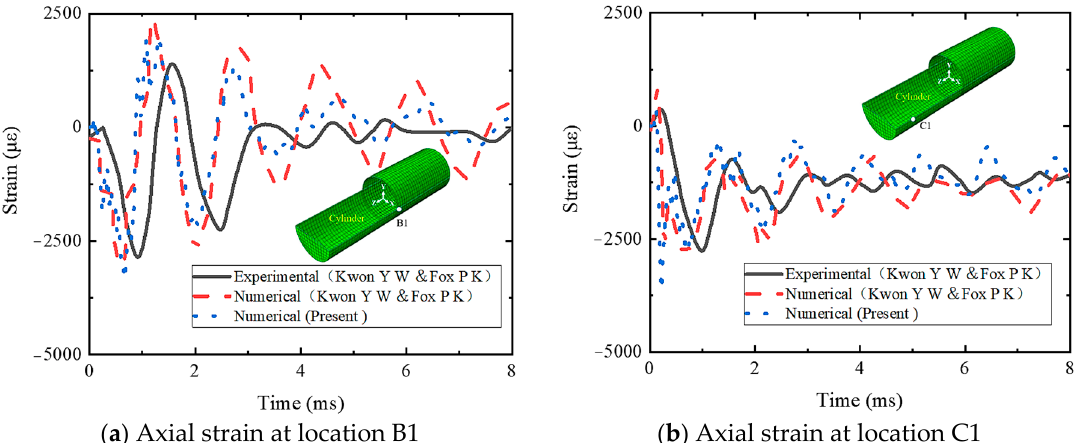
Figure 6. Comparison diagram of experimental and simulation.